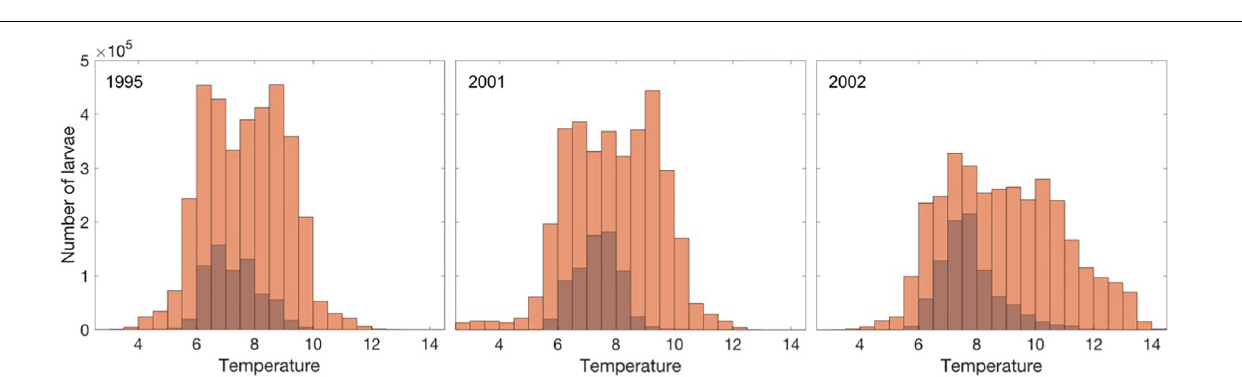
FIGURE 7 | Mean number of days after spawning when growth is prey-limited for the years 1995, 2001, and 2002.